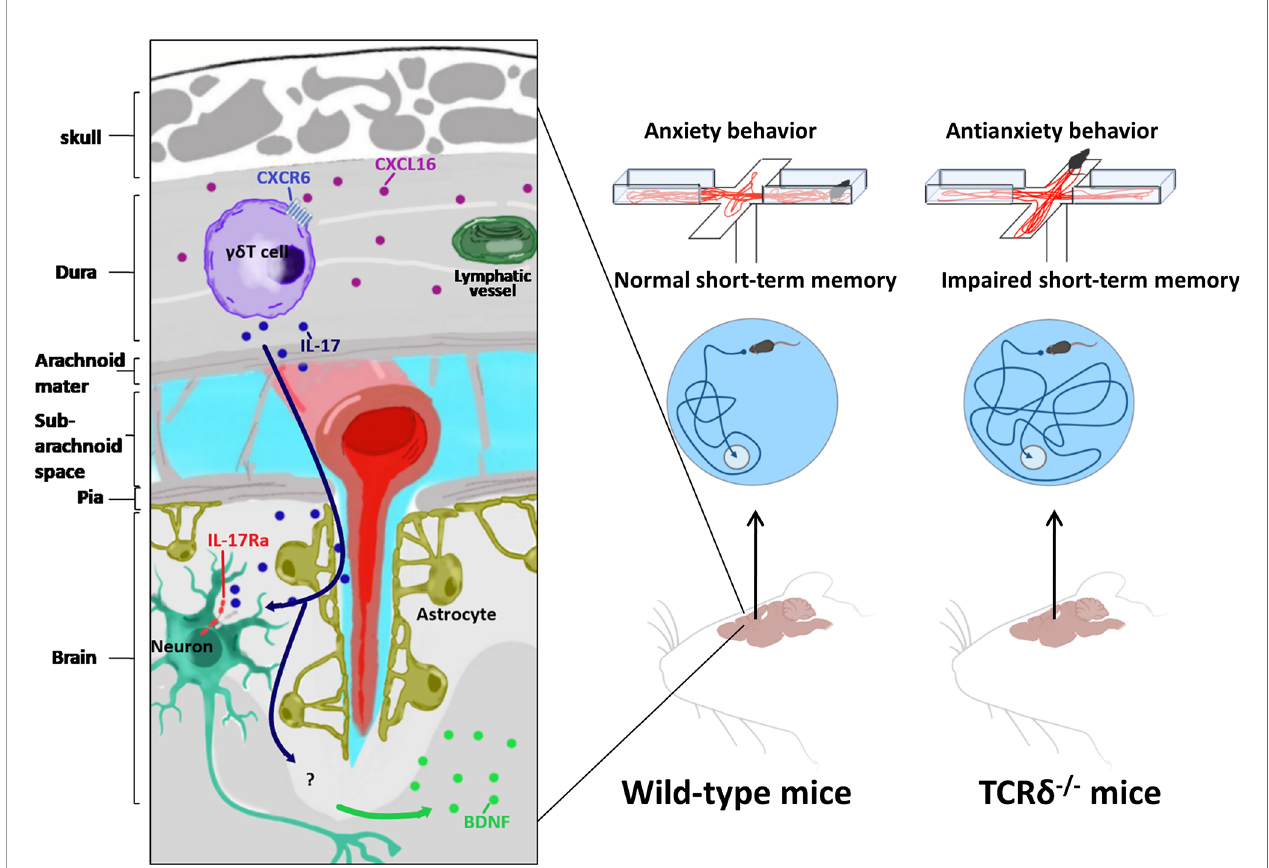
FIGURE 1 | Meningeal gd T cells involved in behavior regulation. Relying on CXCR6-CXCL16 axis, meningeal gd T cells migrate to dura mater shortly after birth. Meningeal gd T cells in fl uence brain by constant secretion of IL-17. Neurons in medial prefrontal cortex(mPFC) and somatosensory cortex (S1DZ) express IL-17Ra in response to IL-17 to regulate anxiety-like behavior of mice. IL-17 induced glial brain-derived neurotrophic factor (BDNF) modulates hippocampal neuronal plasticity to maintain short-term